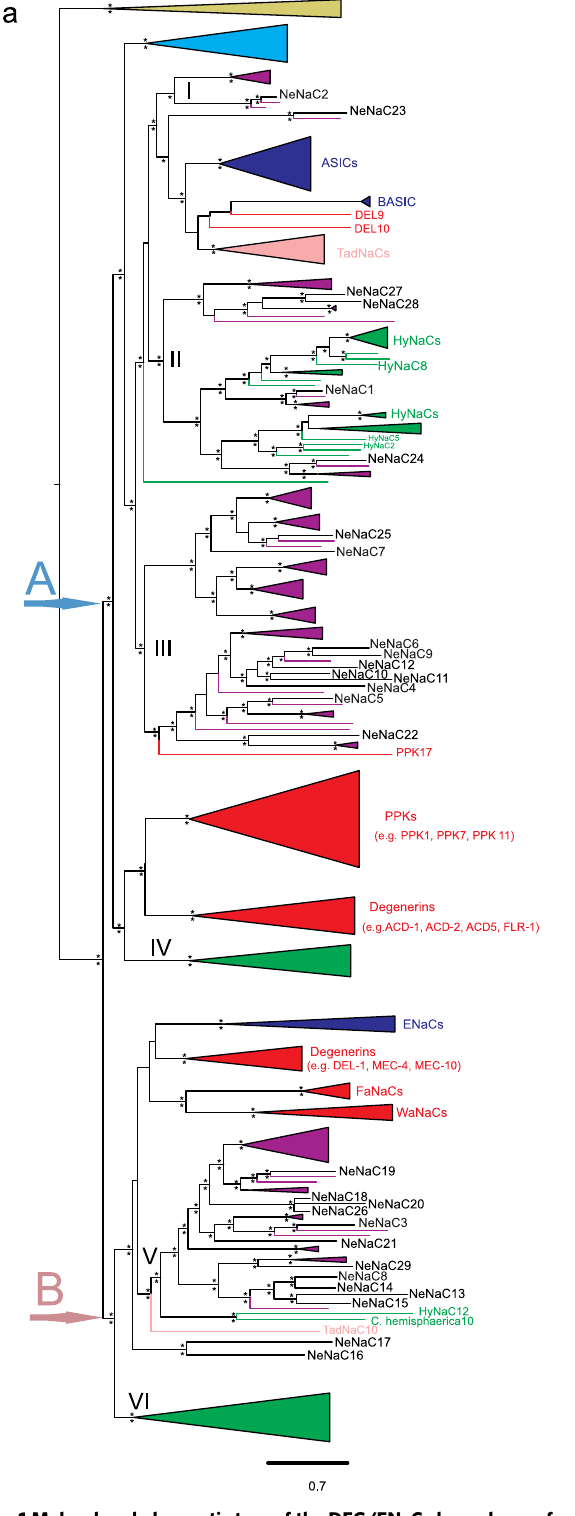
COMMUNICATIONS BIOLOGY| (2023) 6:17